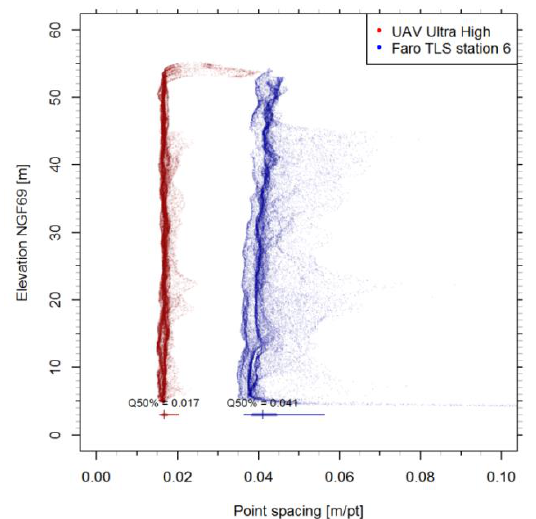
Figure 5 : Comparison of point cloud density variation with cliff height between UAV and TLS point cloud. UAV point density stays constant with